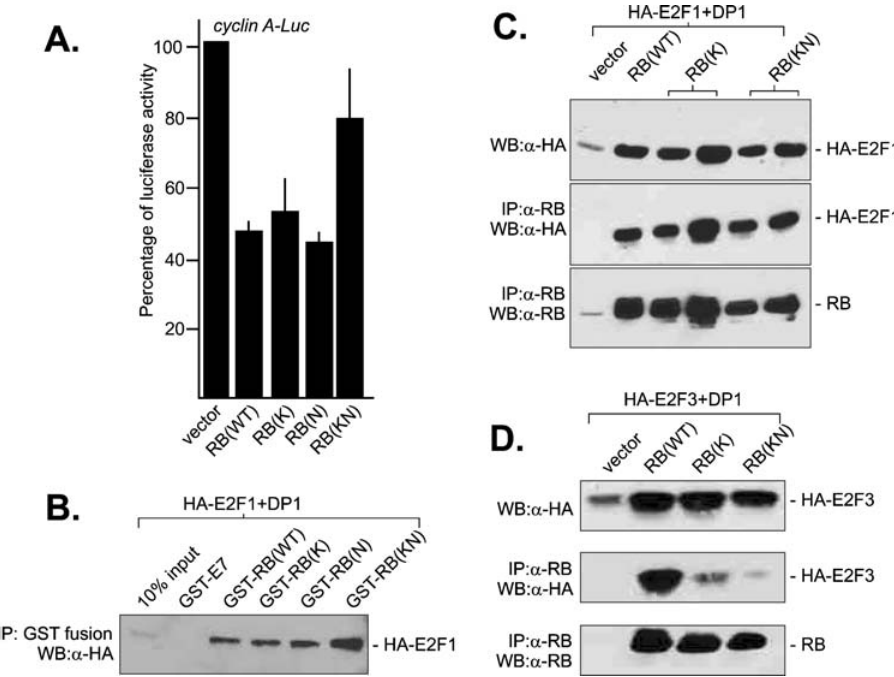
Figure 2. Interaction of RB with E2F/DP1 complex. A) Transcription repression. The Cyclin A-Luc reporter plasmid contains a firefly luciferase expression cassette preceded with a fragment from the human Cyclin A promoter containing E2F-binding site [24]. The reporter was transfected into SAOS-2 cells with the indicated RB expression plasmid and the control Renilla luciferase reporter. The normalized firefly luciferase activity from vector co-transfected cells was set at 100%. B) GST pull-down assay. Lysates from 293T cells expressing HA-tagged E2F1 and DP1 were incubated with the indicated GST-RB and GST-E7 proteins immobilized on glutathione Sepharose. The HA-E2F1 in the bound fraction was resolved by SDS-PAGE and detected by immunoblotting with an anti-HA antibody ( a -HA). C) Co-immunoprecipitation. The RB-deficient C33A cells were co-transfected with HA- E2F1, DP1 and the indicated RB expression plasmids. Whole cell lysates were incubated with anti-RB antibody ( a -RB), and the co-immunoprecipitated E2F1 examined by immunoblotting with an anti-HA antibody ( a -HA). D) GST-pull down assay with E2F3. Lysates from 293T cells expressing HA- tagged E2F3 and DP1 were incubated with the indicated GST-RB and GST-E7 proteins immobilized on glutathione Separose. The amount of E2F3 in the bound fraction was determined by immunoblotting with anti-HA antibody ( a